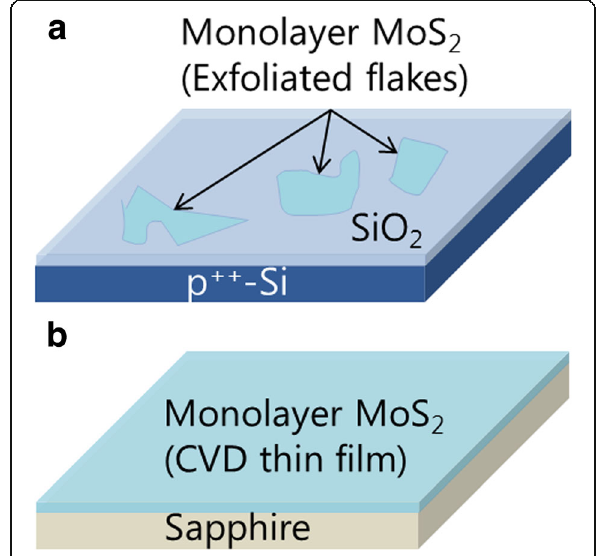
Fig. 1 Schematic structures of MoS 2 monolayers: a mechanically exfoliated flakes on SiO 2 /Si substrates and b CVD thin films on sapphire